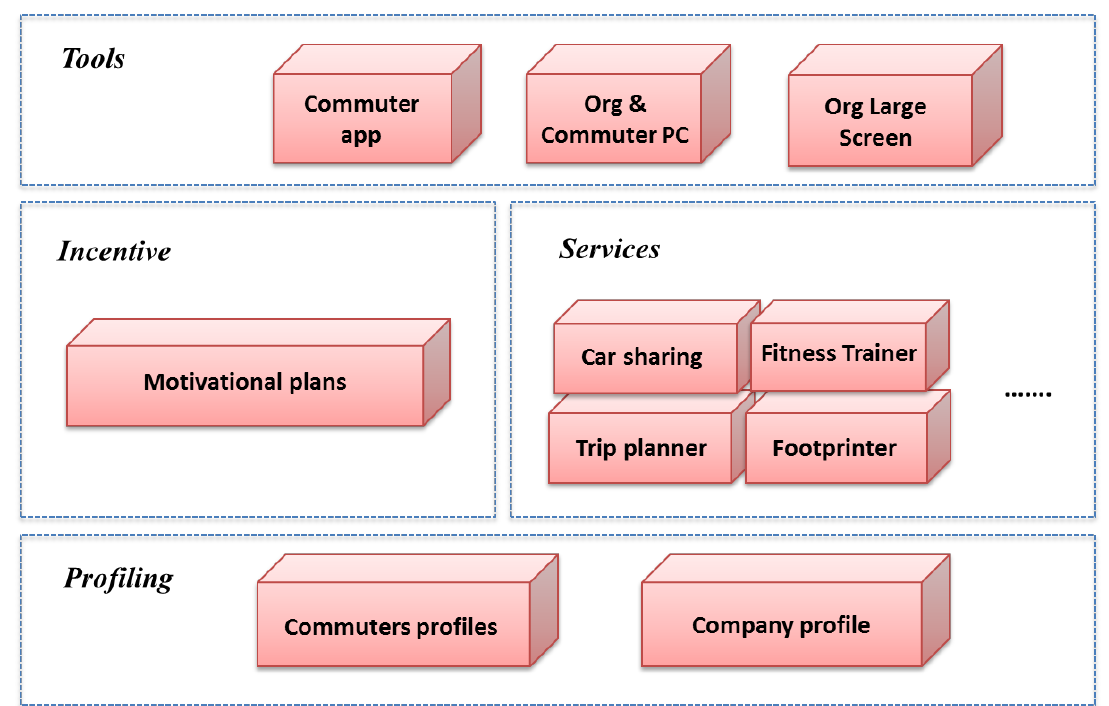
Figure 1 . High level vision and functional architecture of the Sustainable Commuting